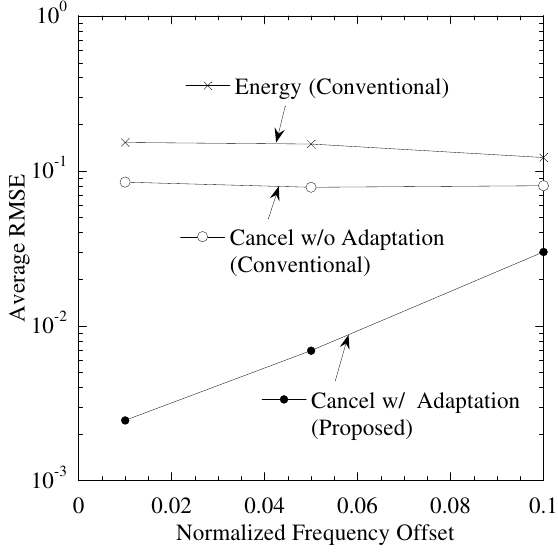
Figure 7. Performance between maximal frequency offset and